Question: In a single sentence, describe what this figure presents.
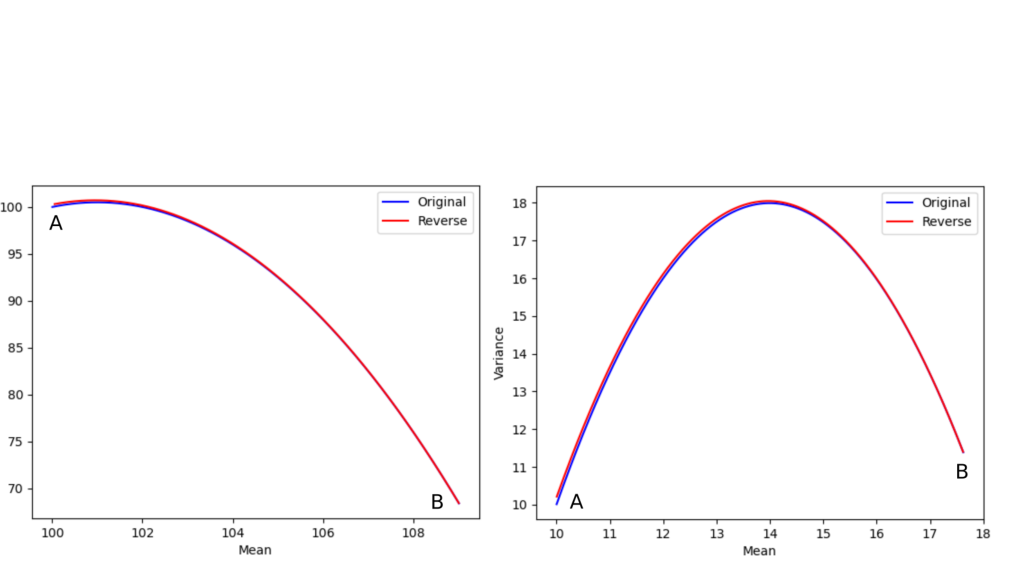
Answer: illustrates some of the geodesic curves obtained during our simulations. The blue curve is built during the regular execution of the fourth-order Runge-Kutta method and the red curve is built during the time reversed version of the simulation. Note that the curves are almost identical, suggesting that the dynamics modeled by the system of differential equations can be considered reversible in time. In the second set of experiments, we use the proposed iterative MCMC based fouth-order Runge-Kutta method to build geodesic curves in the Gaussian random fields manifold using the metric tensor and the Christoffel sym- bols derived in the previous sections. In all simulations, due to the computational cost, the dimensions of each outcome of the random field are 128 × 128, the number of iterations in the MCMC simulation is 100, a = 0, b = 10 and n = 1000, which leads to a step size h = 0.01. Roughly speaking, the intuition behind the numerical simulation of the Euler-Lagrange equatio